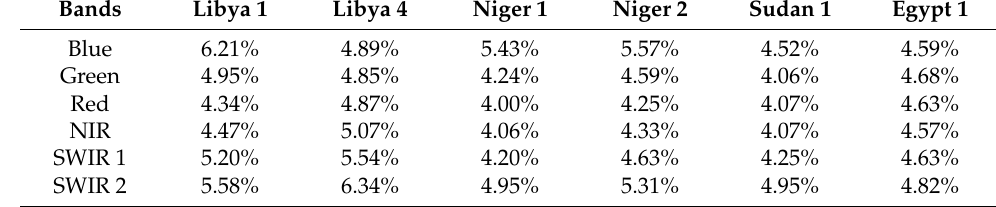
Table 6. Total average estimated uncertainty for all PICS sites in matching spectral bands.